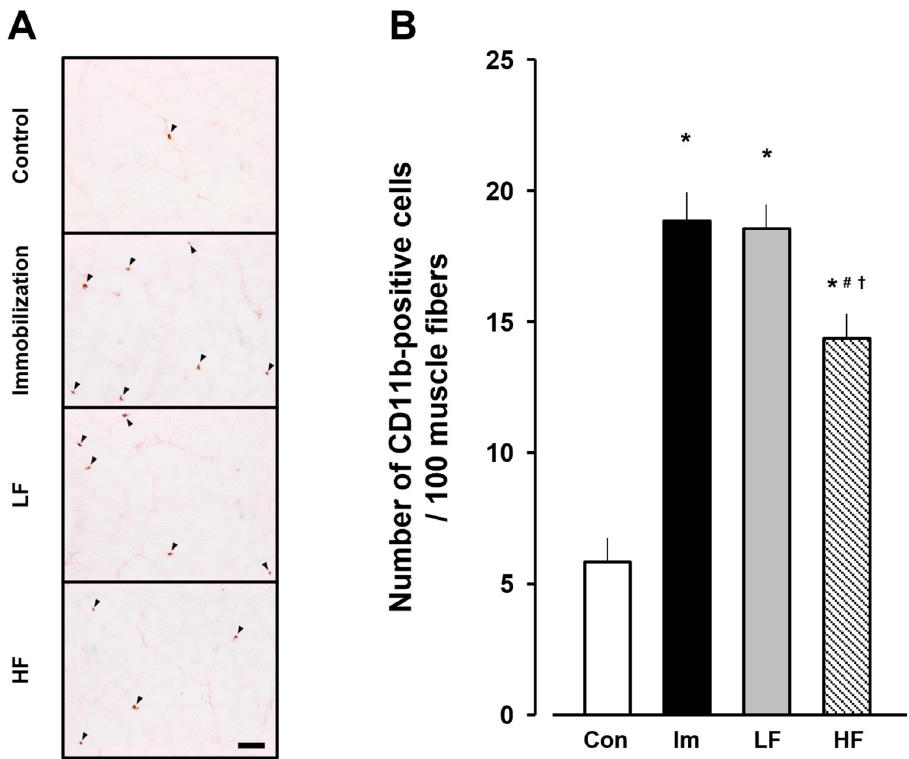
Fig 2. Numbers of CD11b-positive cells in gastrocnemius muscles. (A) Immunohistochemical staining images of CD11b in gastrocnemius muscles. Arrowheads, CD11b-positive cells. Scale bar, 50 μ m. (B) The number of CD11b- positive cells per 100 myofibers. Open bar, control group (Con). Black bar, immobilization group (Im). Gray bar, LF group. Hatched bar, HF group. Data are presented as mean ± standard deviation. � Significant difference (p < 0.05) compared to the control group #Significant difference (p < 0.05) compared to the immobilization group. †Significant difference (p < 0.05) compared to the LF group. LF, low-frequency; HF, high-frequency.